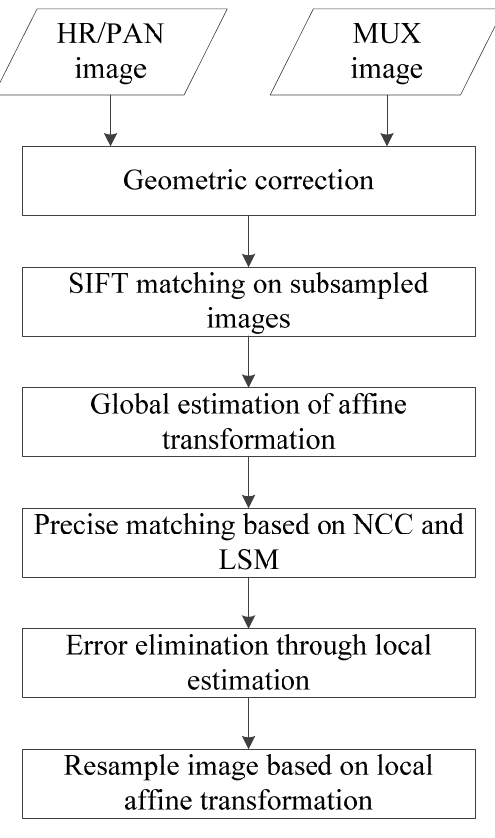
Figure 1. Flowchart of the entire